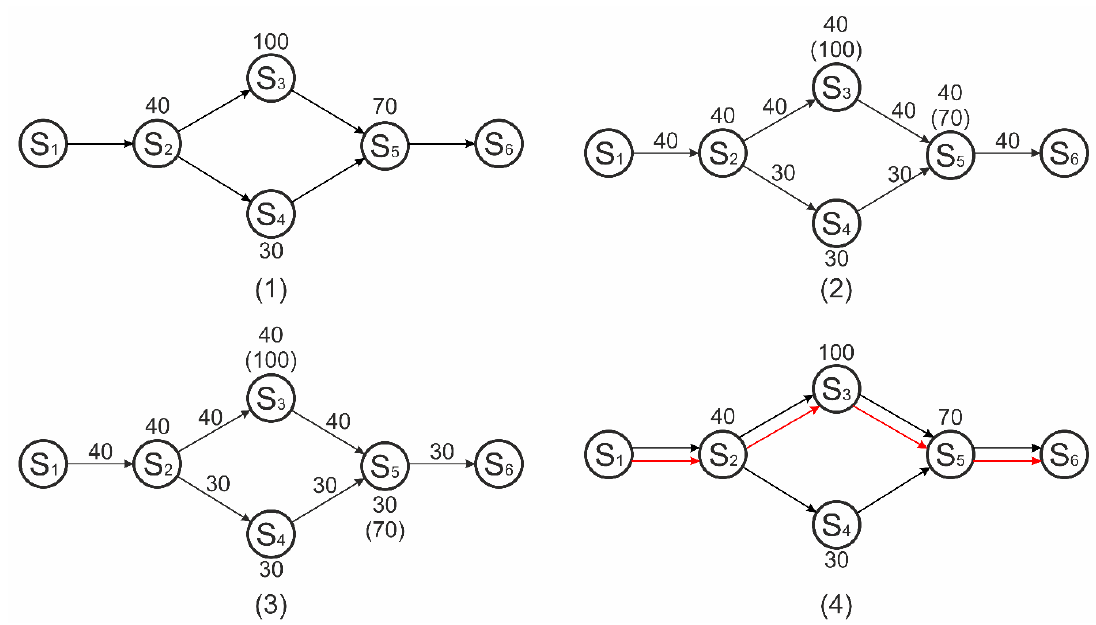
Figure 3. An example of the formation of bandwidth of the communication channels. The next method is to conditionally replace the sensor with two sensors connected by a communication channel with the bandwidth of the selected sensor. After solving